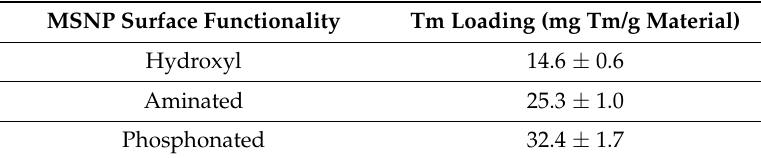
Table 1. Different surface functionalities vs. thulium